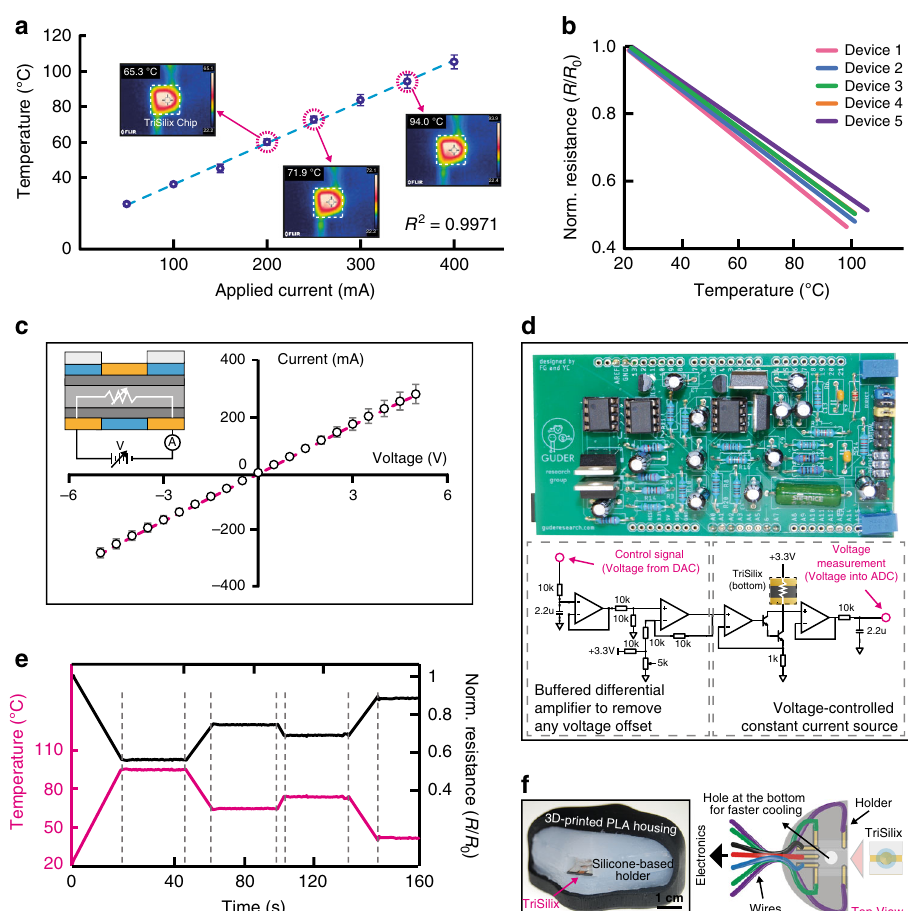
Fig. 3 Characterization of temperature transduction. a Relationship between temperature and (constant) current applied in electrothermal heating ( N = 5). The temperature measurements were cross correlated with a thermal camera as a reference measurement. b Temperature vs normalized resistance (resistance/initial resistance) linear relationship showing a negative slope ( N = 5). c I – V measurements across the Au – Si – Au junction which yielded a linear, ohmic relationship between − 5 and + 5 V ( R 2 = 0.9996, N = 5). d Photograph (top) and simpli fi ed circuit schematic diagram (bottom) of the custom electronics used for heating and temperature sensing. e Temperature program to maintain the TriSilix chip at a temperature setpoint over time using software control and custom electronics. f Photograph (left) and schematic illustration (right) of the silicone-based holder with embedded contacts to run TriSilix in trimodal operation. In all experiments shown in this fi gure, each repeat is performed with a new TriSilix chip and error bars correspond to standard deviations between